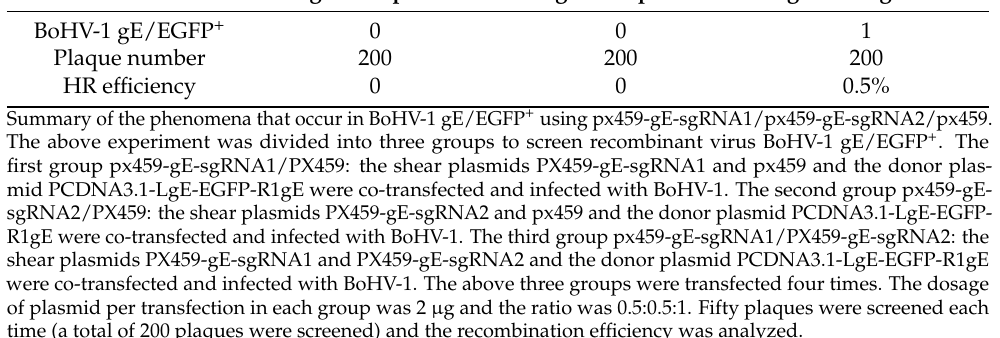
Table 2. The gene editing in BoHV-1 gE/EGFP + using px459-gE-sgRNA1/px459-gE-sgRNA2/px459. px459-gE-